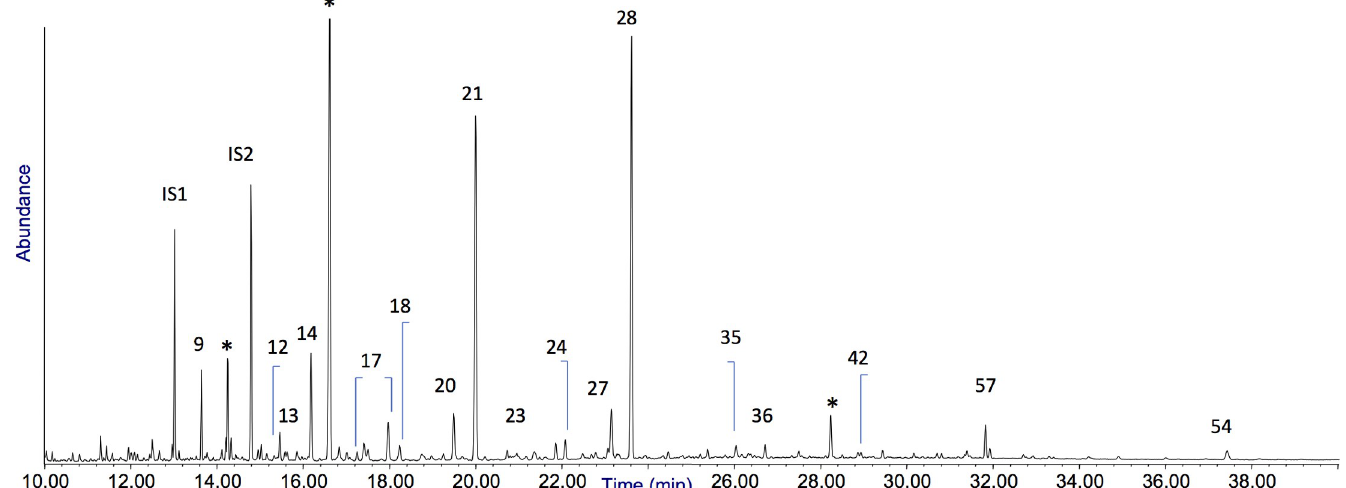
Fig 8. Chromatographic profile obtained for lipid-resinous fraction of sample AGO4 no. 258. The numbers refer to Table 8. IS1 = hexadecane, IS2 = tridecanoic acid, � : phthalate contamination.